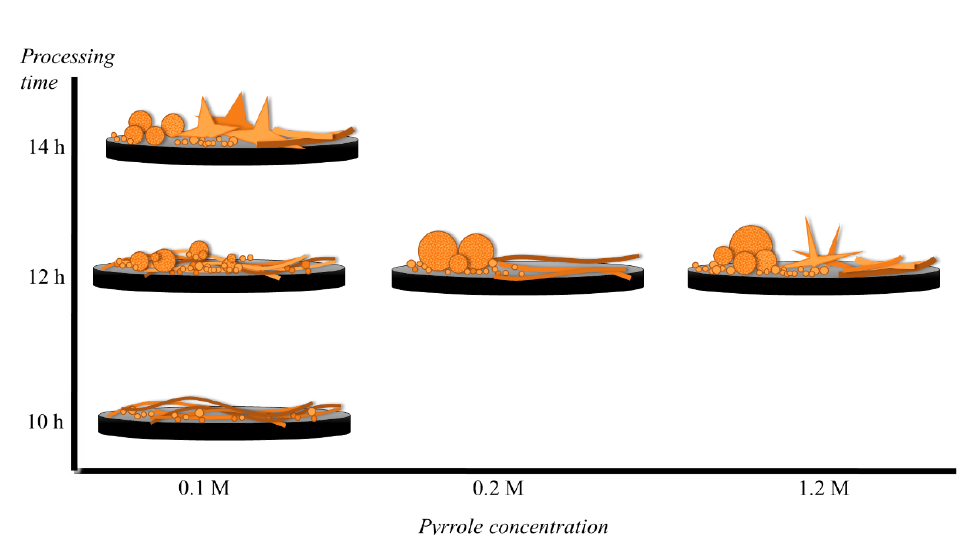
Figure 1. Illustration of the morphology changes as a result of the processing time and pyrrole con- centration variations during the hydrothermal process of copper acetate.